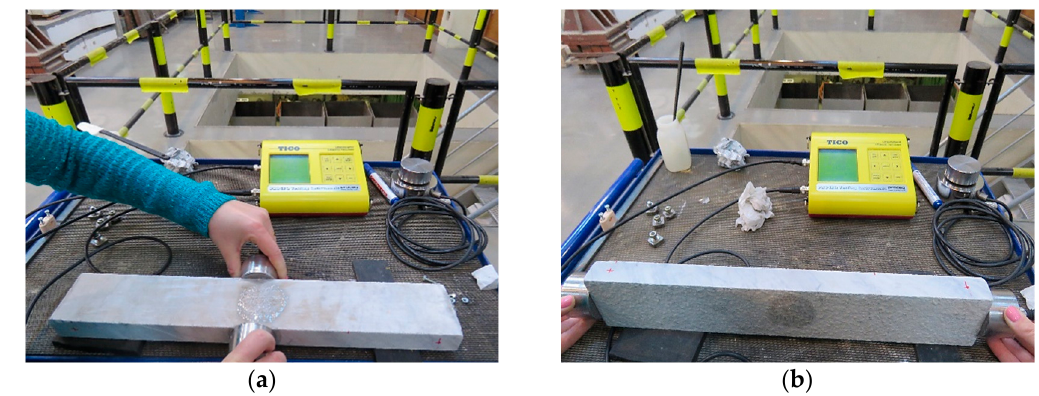
Figure 8. Examples of breaking load at the dowel whole (top side of the specimen is the sun/wind-exposed surface): ( a ) test set-up with loading direction (F); ( b ) specimen after breaking.